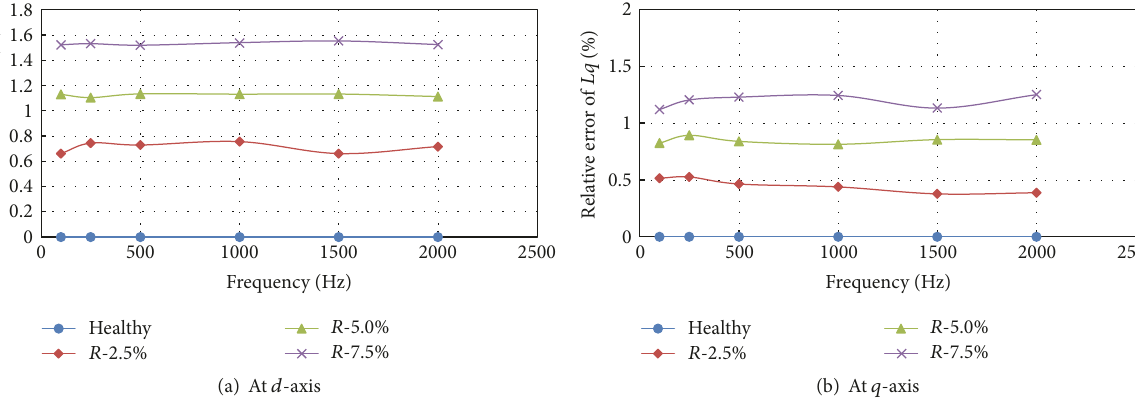
Figure 15: Relative error of measured inductance.